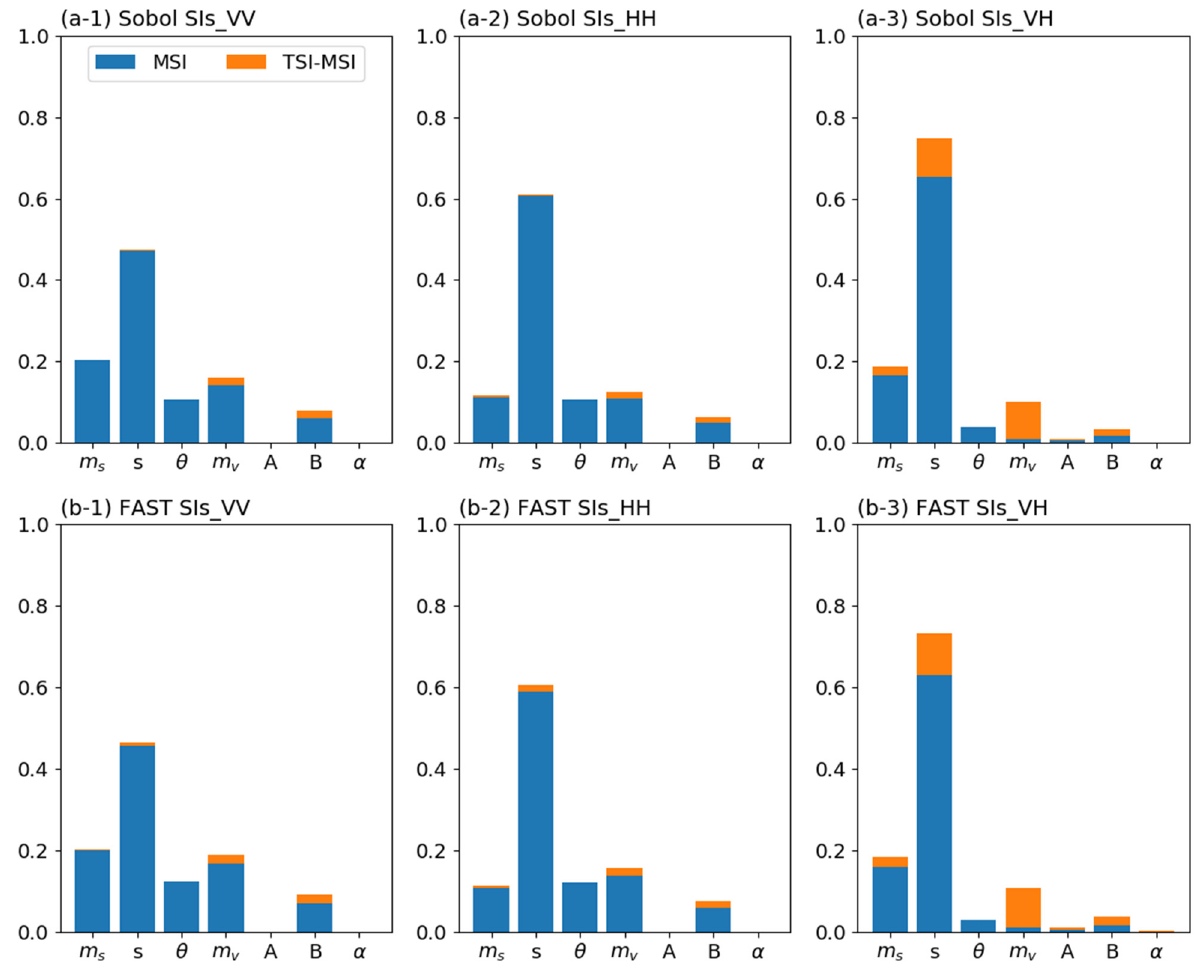
Figure 2. Parameter SIs from the two quantitative methods (Sobol’ and FAST) under Bindlish vegetation description scheme. MSI and TSI-MSI represent the first-order effect (main sensitivity index, MSI) and the difference between total effect (total sensitivity index, TSI) and MSI, respectively.